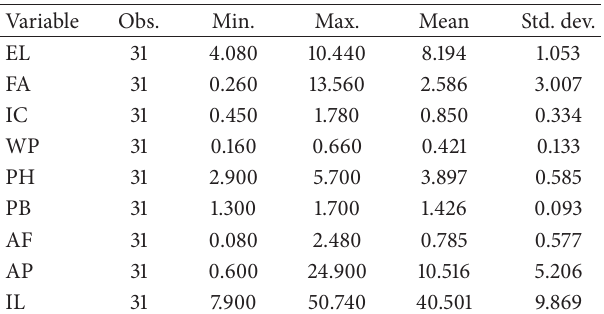
Table 7: Statistical description of influence variables in 31 provinces. Variable